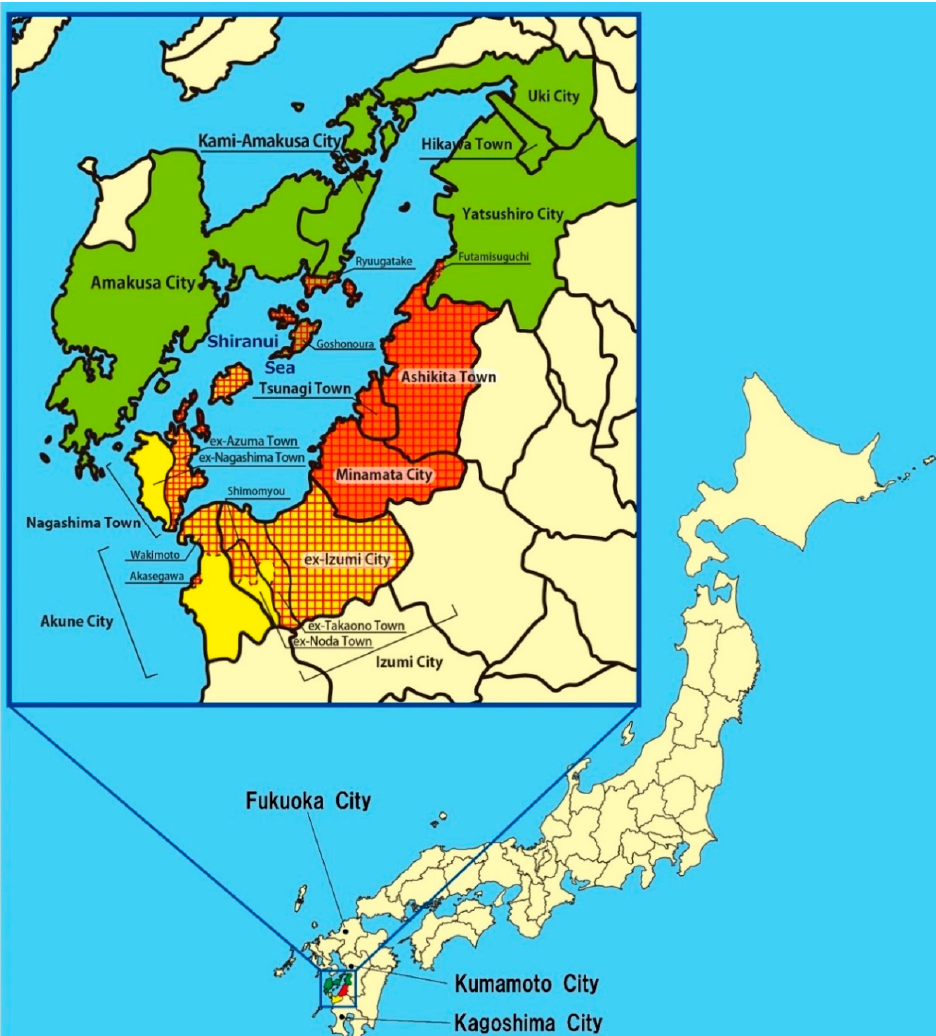
Figure 1. Surveyed area and designated area. Minamata Area: red, Northern Area: green, Southern Area: yellow, Other Areas: beige. Designated Area: red cross-hatched pattern. Control area: around Fukuoka, Kumamoto, and Kagoshima City.